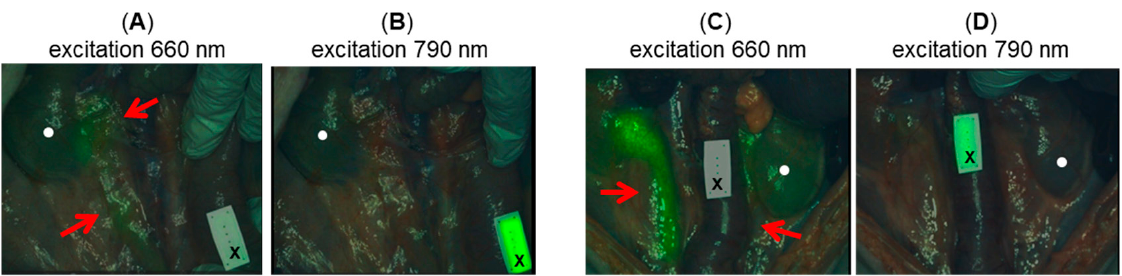
Figure 9. Representative images showing ureter identification in porcine model following treatment with 12 and ICG (0.5 mg/kg). ( A ) Image taken 120 min post administration of 12 (0.1 mg/kg) following administration of ICG using 660 nm excitation and ( B ) using 790 nm excitation. Note ICG reference card is not fluorescent in A and is fluorescence in B, with ureter fluorescence in A but not in B. ( C ) Image taken 120 min post administration of 12 (0.25 mg/kg) following administration of ICG using 660 nm excitation and ( D ) using 790 nm excitation. Note ICG reference card is not fluorescent in C and is fluorescent in D, with ureter fluorescent in C but not in D. Red arrows indicate ureters and circle indicates kidneys.